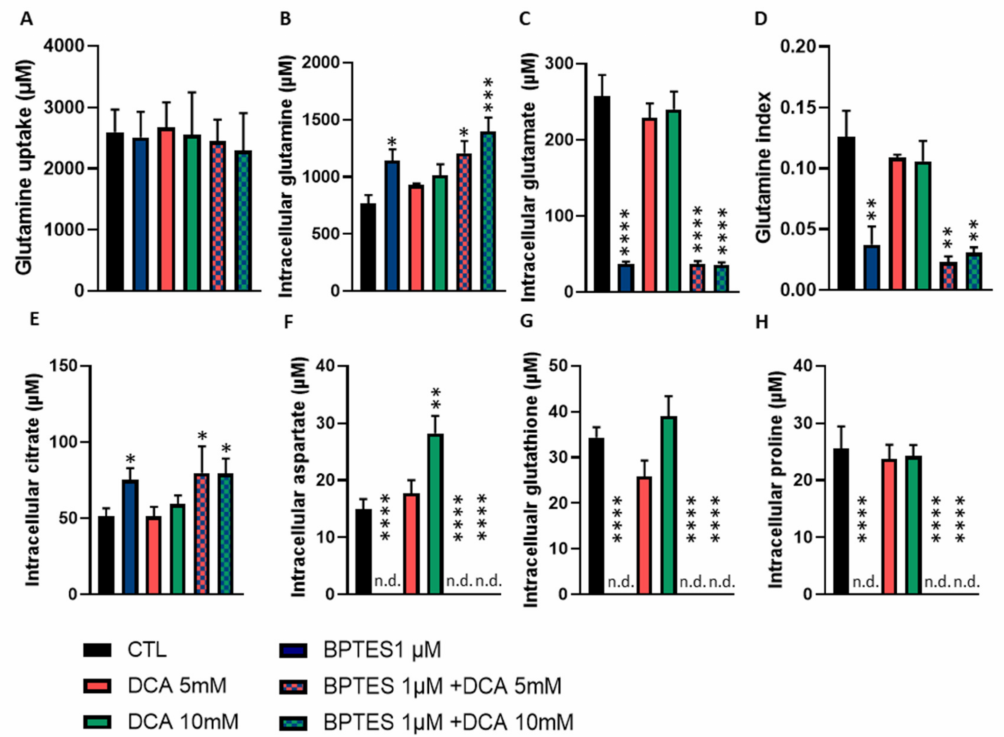
Figure 5. Downstream metabolites of glutamine are di ff erentially impacted by BPTES and DCA. ( A – H ), HUVECs were exposed during 24 h to 10 mM of l -glutamine-5-13C and co-incubated with or without DCA (5 or 10 mM) and BPTES (1 µ M), alone and in combination. Intra- and extracellular metabolites were quantified by 13 C NMR spectroscopy ( n = 5). ( A ), glutamine uptake. ( B ), intracellular glutamine concentration. ( C ), glutamate production from glutamine. ( D ), glutamine index, ratio of glutamate production on glutamine uptake. ( E ), citrate production from glutamine. ( F ), aspartate production from glutamine. ( G ), glutathione production from glutamine. ( H ), proline production from